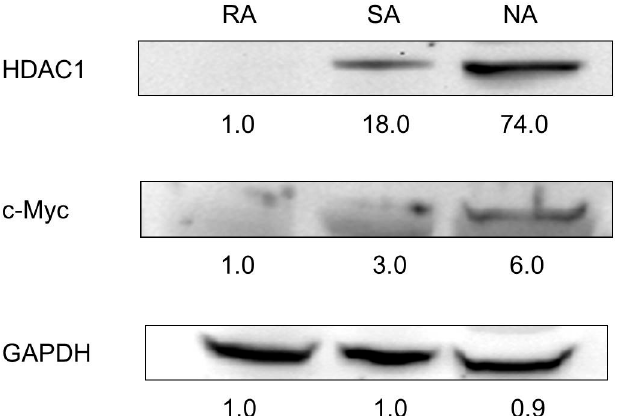
Figure 7. Expression of HDAC1 in three keratinocyte groups. RA, SA, and NA cells were subjected to a Western blot analysis with antibodies against HDAC1 and c-Myc. Equal protein loadings were confirmed using anti-GAPDH antibody. HDAC1 was not expressed in RA cells. HDAC1, histone deacetylases 1, RA, rapidly adhering, SA, slowly adhering, NA, non-adhering.